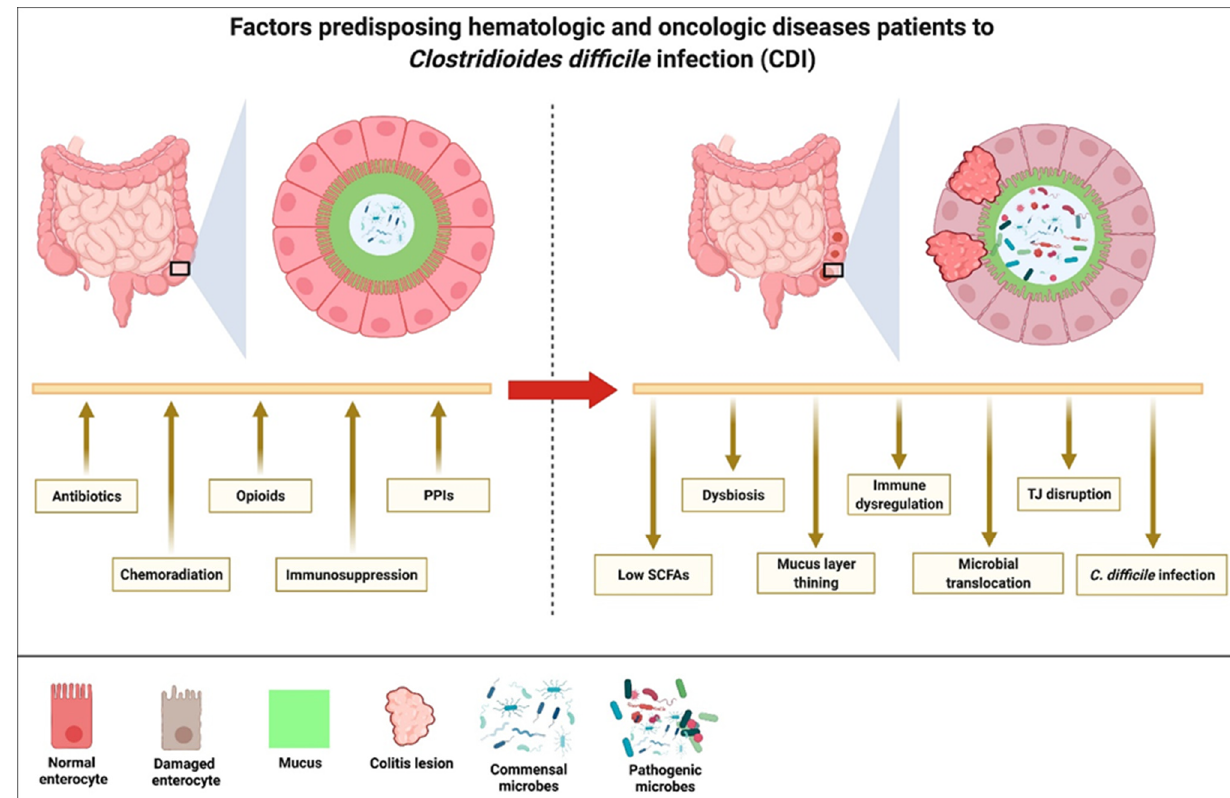
Figure 3. Patients with hematologic and oncologic diseases are more likely to develop Clostridioides difficile infection due to the frequent use of antibiotics, opioid analgesia and proton pump inhibitors, chemoradiation, and immunosuppressive agents. As a result, a change in the intestinal microbial composition and integrity of the epithelium results in the reduced production of short chain fatty acids, intestinal dysbiosis, thinning of the mucin layers, immune dysregulation, interruption